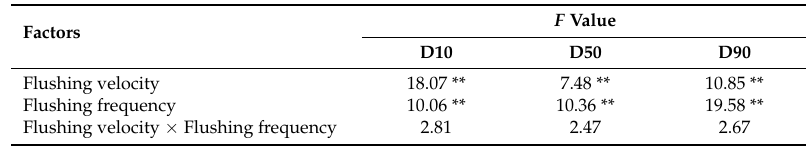
Table 5. Variance analysis of the effects of flushing velocity and frequency on the particle size of residual sediments in emitters.